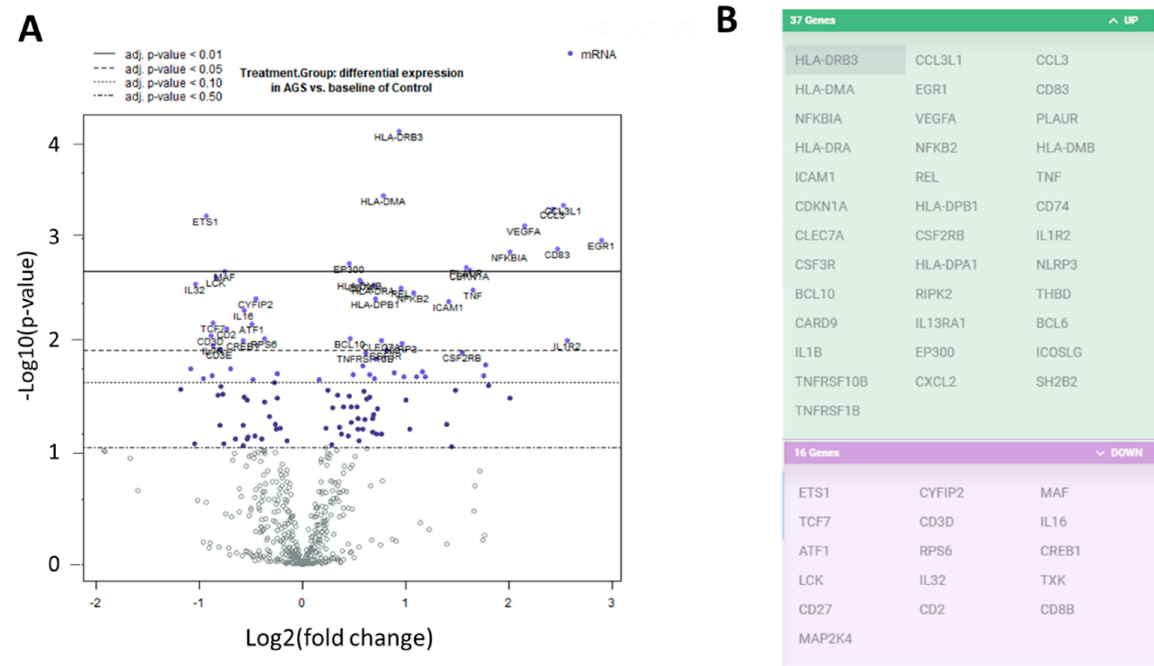
Figure 2. Differentially expressed genes in peripheral blood mononuclear cells (PBMCs) from alpha-gal allergic participants compared to controls. ( A ) Volcano plots show − log10( p -value) and Log 2 fold change in gene expression for AGS participants compared to control. Highly statistically significant genes are at the top of the plot above the horizontal lines, which represent the p -value thresholds adjusted using the Benjamini–Hochberg method of estimating false discovery rates (FDR). Highly differentially expressed genes fall to the left and right. There are 81 genes wherein the adjusted p -value for differential gene expression is p < 0.05, and 53 genes wherein the adjusted p -value is p < 0.02. The 40 most statistically significant genes are labeled in the plot. ( B ) The graphic lists the 53 genes with adjusted p -value < 0.02. The 37 gene transcripts that are highlighted in green were upregulated, and the 16 gene transcripts highlighted in purple were downregulated, in AGS compared to control.